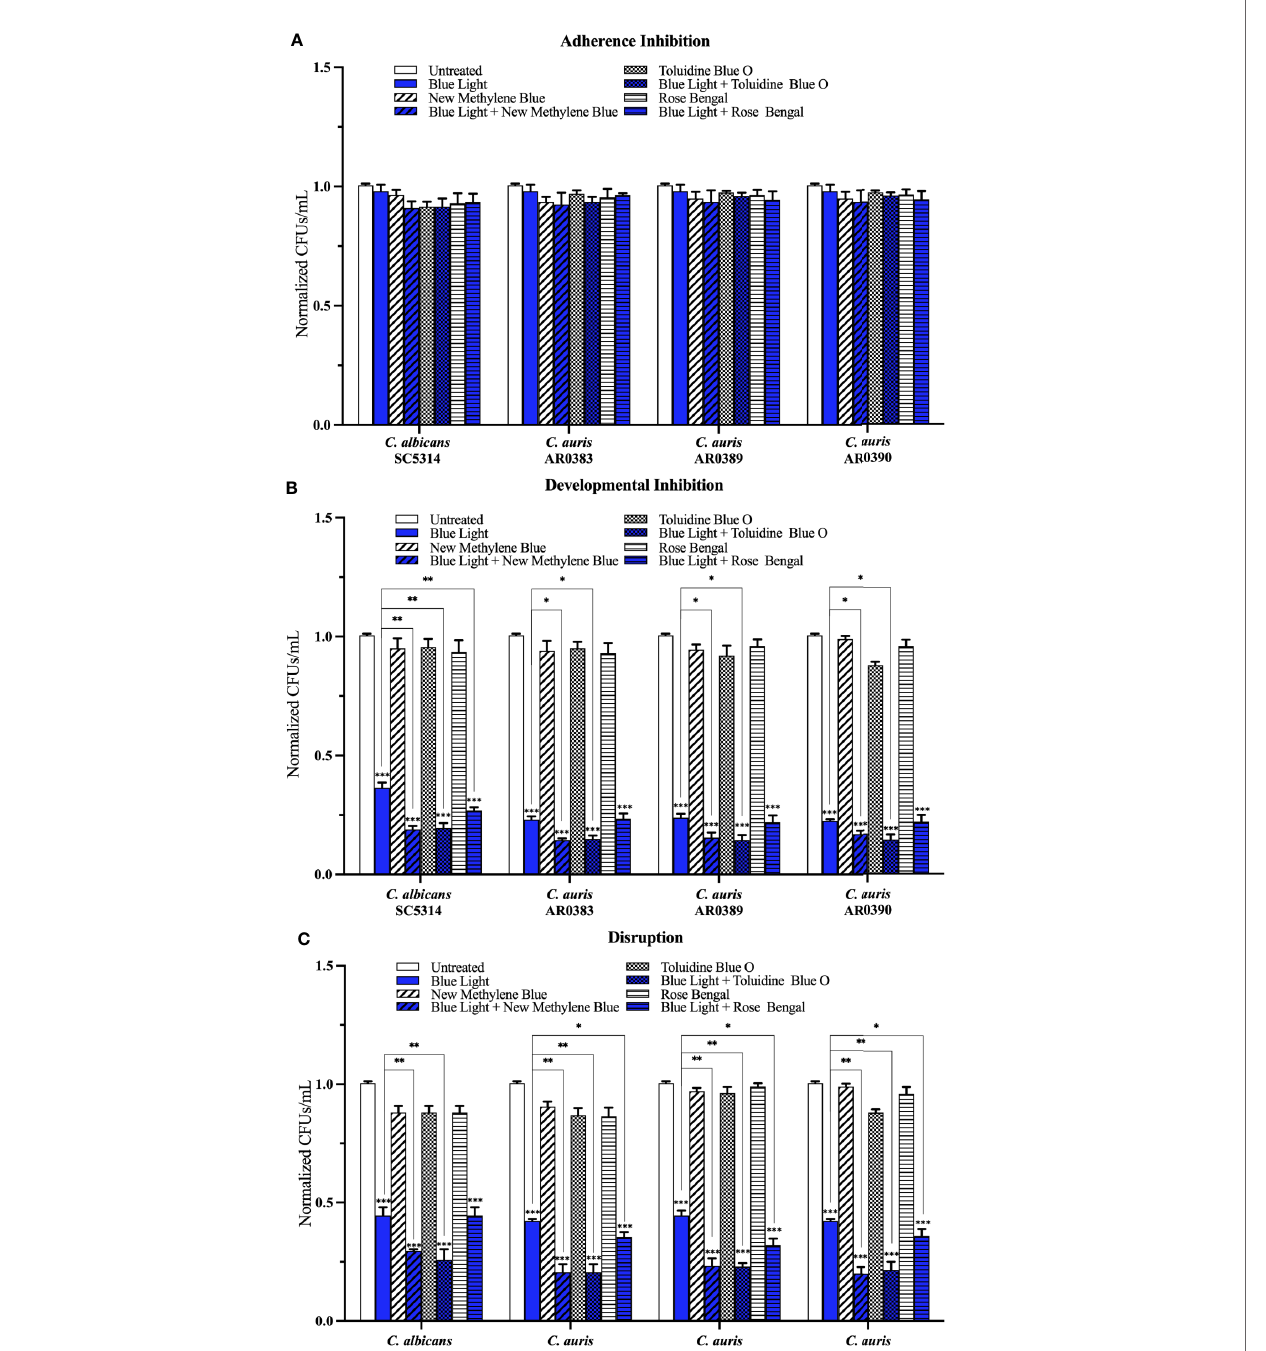
FIGURE 5 | Blue visible light in combination with photosensitizing compounds is effective against C . auris bio fi lms. C. albicans (SC5314) and C . auris (AR0383, AR0389, and AR0390) bio fi lms were exposed to blue visible light with and without the photosensitizing compound indicated in the (A) adherence inhibition, (B) developmental inhibition, and (C) disruption bio fi lm assays. Untreated control (Untreated), blue light alone (Blue Light), photosensitizing compound alone (New Methylene Blue, Toluidine Blue O, and Rose Bengal), and blue light in combination with the photosensitizing compounds (Blue Light + New Methylene Blue, Blue Light + Toluidine Blue O, and Blue Light + Rose Bengal) are shown. CFUs/mL were counted to determine viable cell counts at the end of each of the bio fi lm assays. Standard deviations are shown for each sample (n = 3). The average CFUs/mL of the untreated control samples for each assay were normalized to 1. Signi fi cance comparisons are relative to the untreated control unless otherwise noted with signi fi cance bars and were determined using student ’ s unpaired two-tailed t-tests assuming unequal variance for p ≤ 0.05 (*), p ≤ 0.01 (**), and p ≤ 0.001